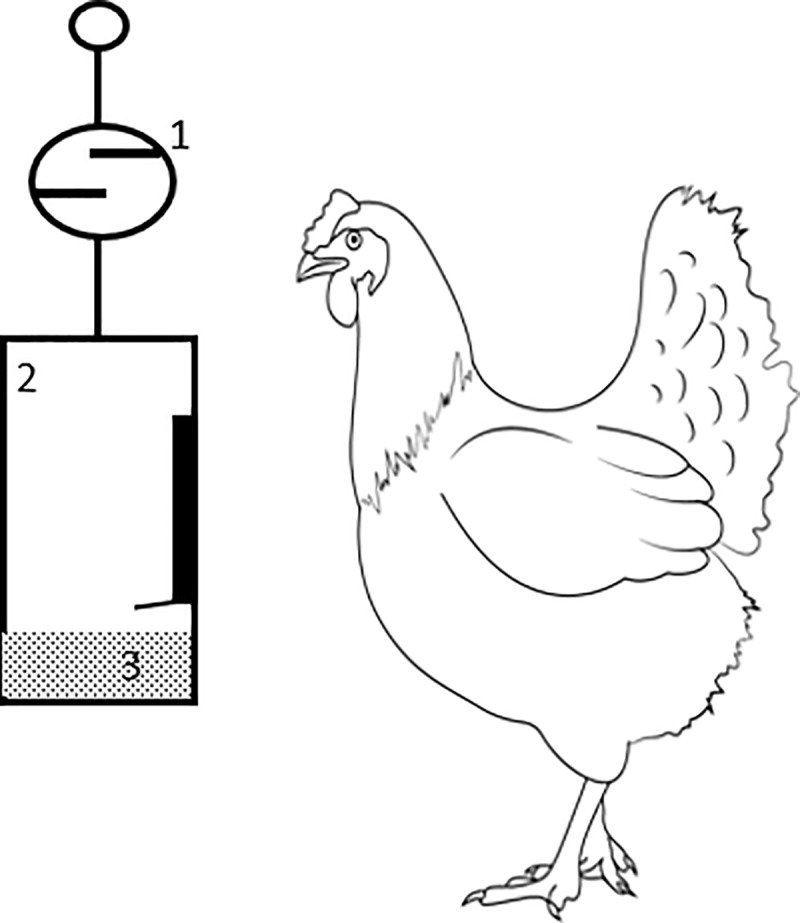
Scale system with layer hen; 1 –wireless analogue ‘pull’ load cell sensor; 2—bottle with opening and lip to prevent feed spillage; 3—feed.